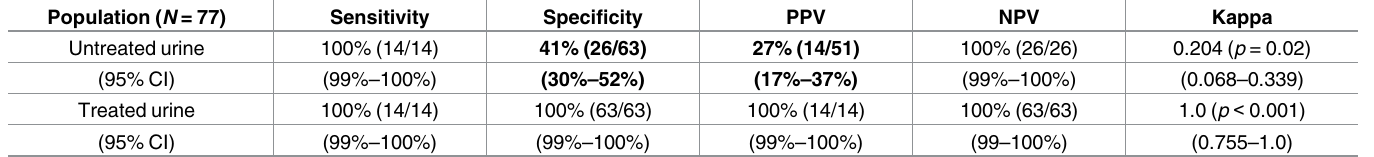
Table 1. Summaryof the diagnostic performance of cryptococcal antigen lateral flow assay on urine samples using serum as the reference